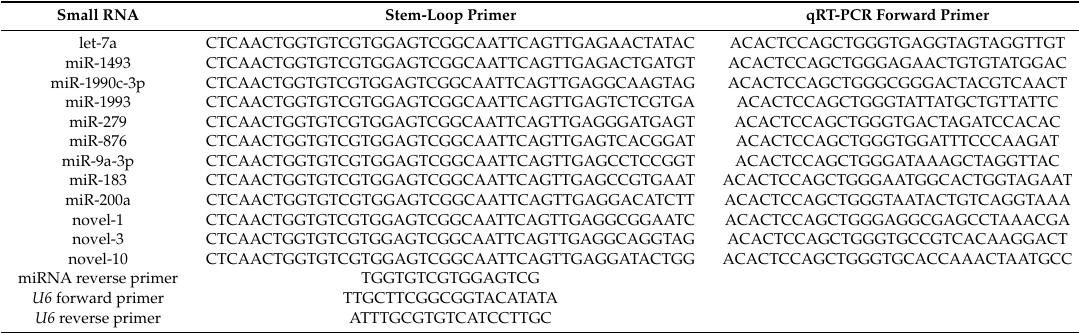
Table 1. Primers used in the present study.